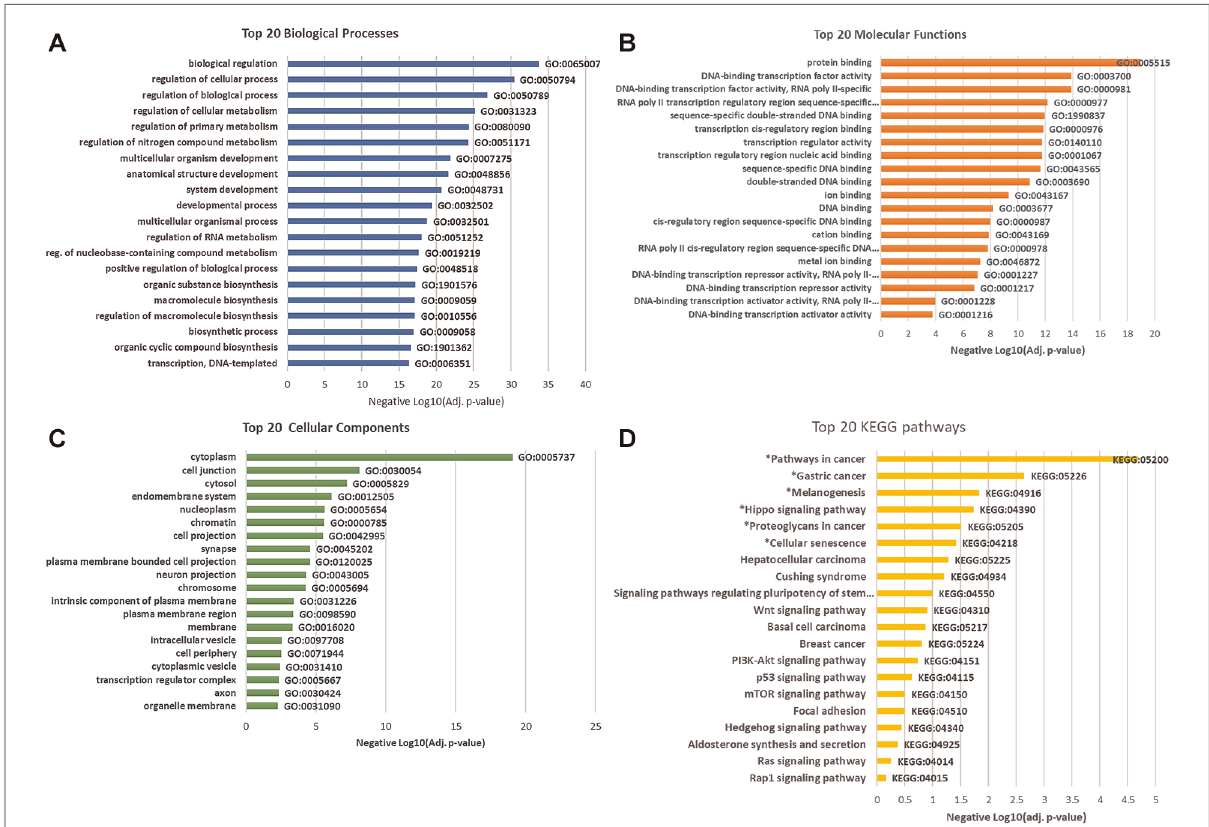
FIGURE 4 Go and KEGG pathway enrichment by differentially methylated gene in low vs. high stigma showing biologically processes ( A ) Molecular functions ( B ) Cellular components ( C ) and KEGG pathways ( D ). All depicted GO were signi fi cant and *denotes signi fi cant KEGG pathways (adj. p